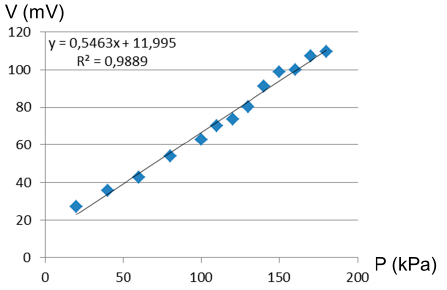
Figure 15. The amplitude of the action potential in function of air pressure of the Quake valves. The amplitude can be tuned from 20 to 115 mV.